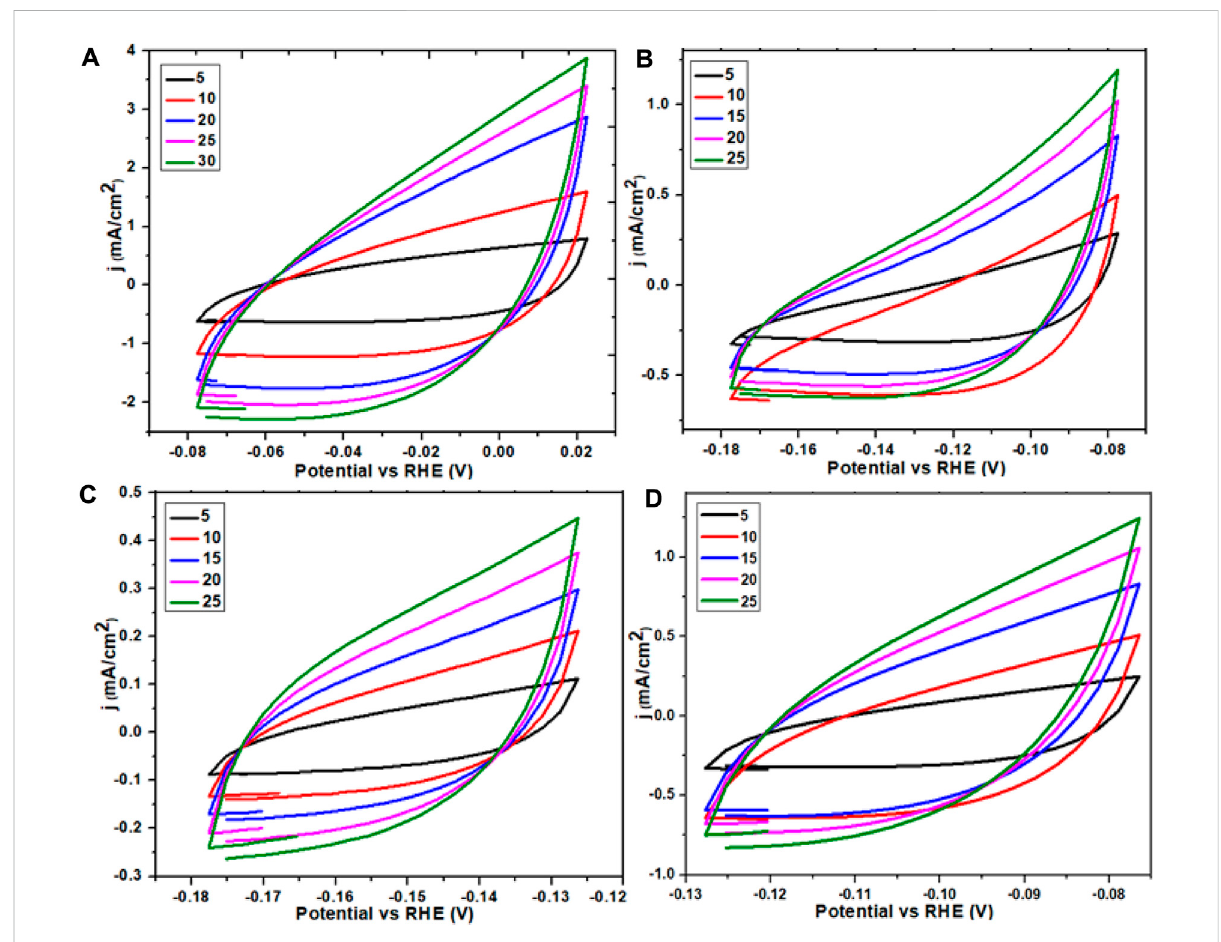
FIGURE 11 ECSAgraph ofCe-MOF andstraightlineplotofscanratevs. Δ j (A,B) andECSAgraphofcalcinated Ce-MOFandstraightline plotofscanratevs. Δ j (C,D)